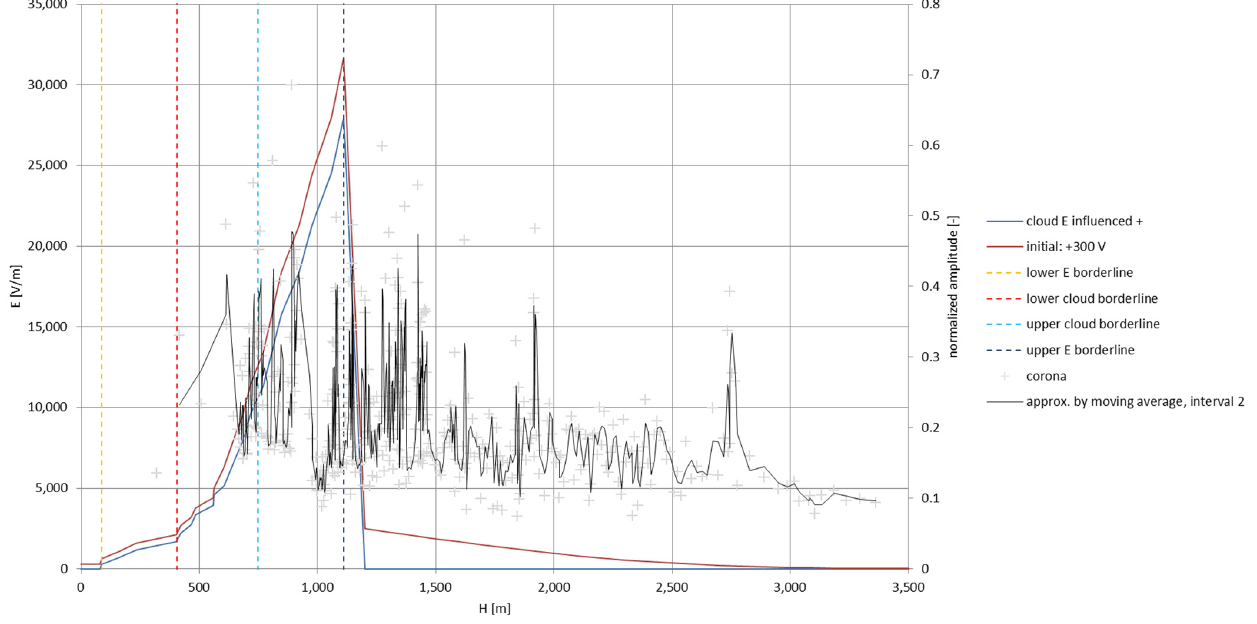
Figure 24. The comparison of the corona discharges plotted as a 2nd-order moving-average spline with the dynamic electrification of the airborne antenna moving through a positively polarized Sc cloud.